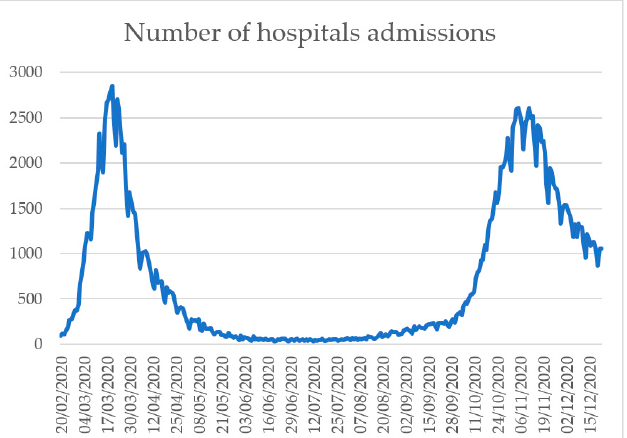
Figure 3. Trend of hospitalizations due to COVID-19, 20 February 20–22 December 2020 (modified from [40]).